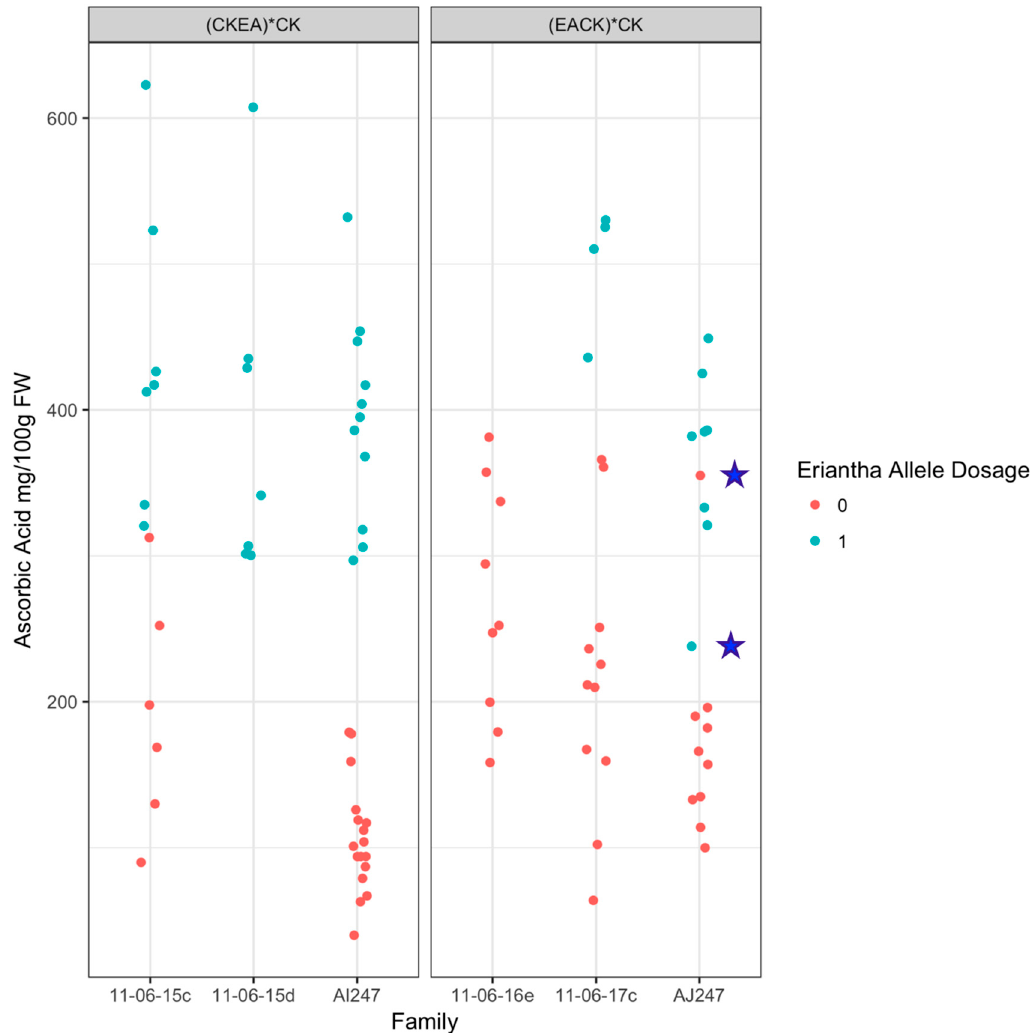
Figure 6. Segregation of the high-resolution melting (HRM) marker KCH00062 in relation to fruit AsA content in six diploid backcross Actinidia families. Panels denote back cross type (CKEA*CK ( A. chinensis × A. eriantha ) × A. chinensis ; EACK*CK ( A. eriantha × A. chinensis ) × A. chinensis ). Two putative recombinants are denoted by stars.